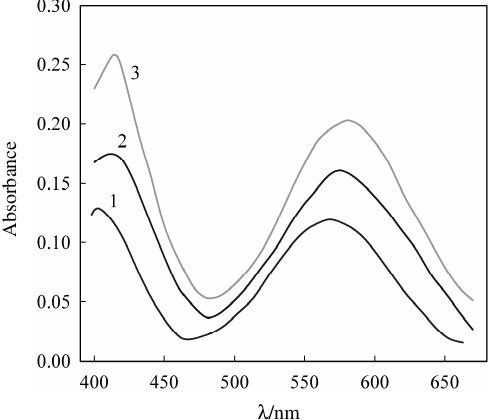
Figure 1. Visible spectra in aqueous Cr(III) solutions (0.01 M Cr(III)), (1) chromium(III) perchlorate (violet form) ; (2) chromium(III) methanesulphonate (fresh prepared violet form) ; (3) chromium(III) methanesulphonate (green form obtained after keeping solution